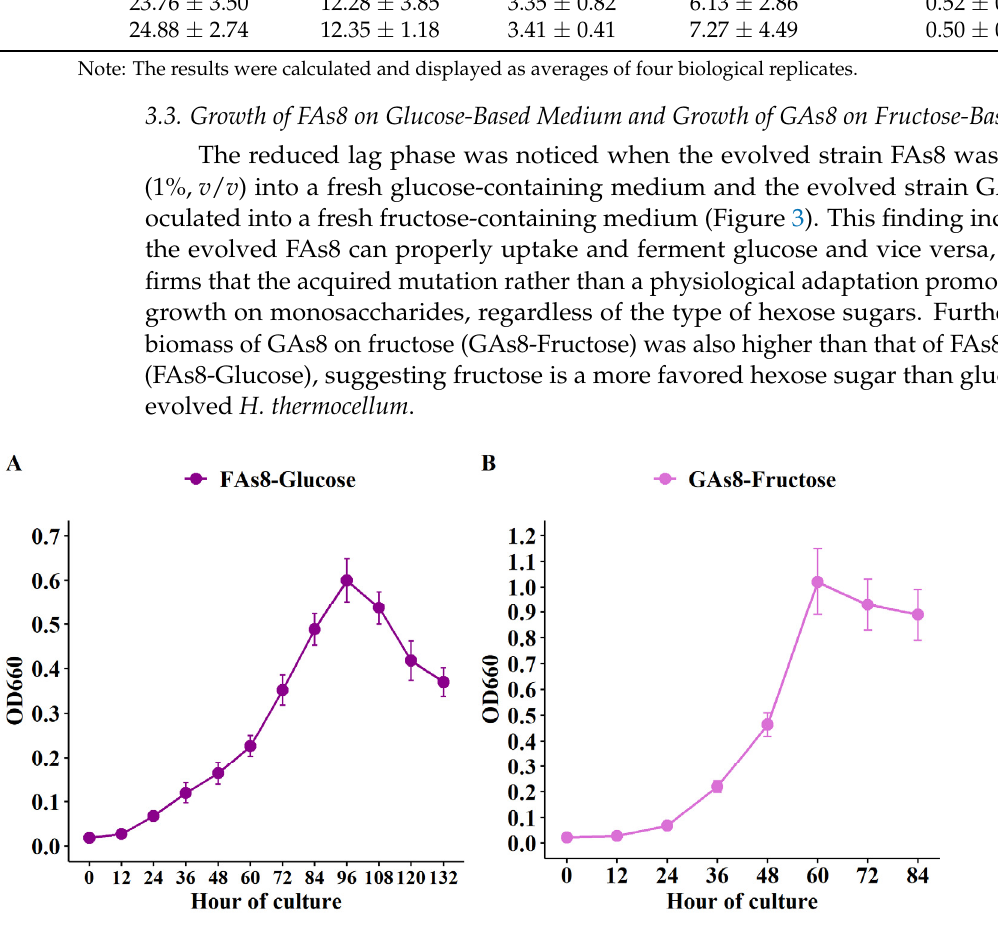
Note: The results were calculated and displayed as averages of four biological replicates.